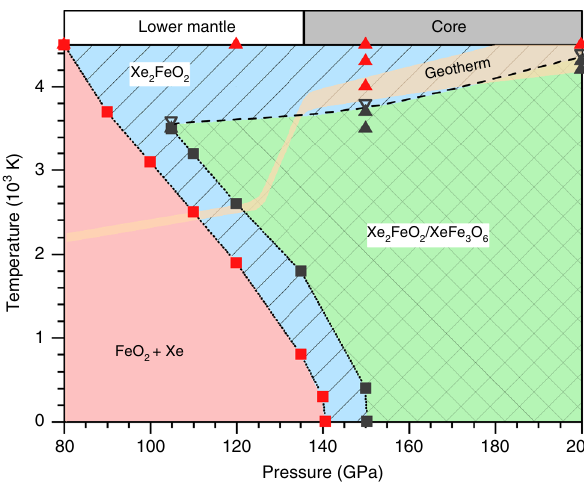
Fig. 4 The Pressure – temperature ( P – T ) phase diagram of the Xe-FeO 2 system. The dotted and dashed lines indicate phase boundaries and temperature-driven phase instability, which are determined by Gibbs free energy and ab initio molecular dynamics (AIMD) calculations, respectively. The square symbols show phase transition points based on relative Gibbs free energy, and the solid and open triangle symbols represent stable and temperature-driven unstable solid phases, respectively, determined by AIMD simulations. The P – T regions of stable Xe 2 FeO 2 are covered by slash lines and the P – T regions of stable XeFe 3 O 6 are fi lled by back-slash. The pressure boundary between the lower mantle and the core is shown at the top of the fi gure. Also shown is the geotherm of the Earth ’ s interior 65